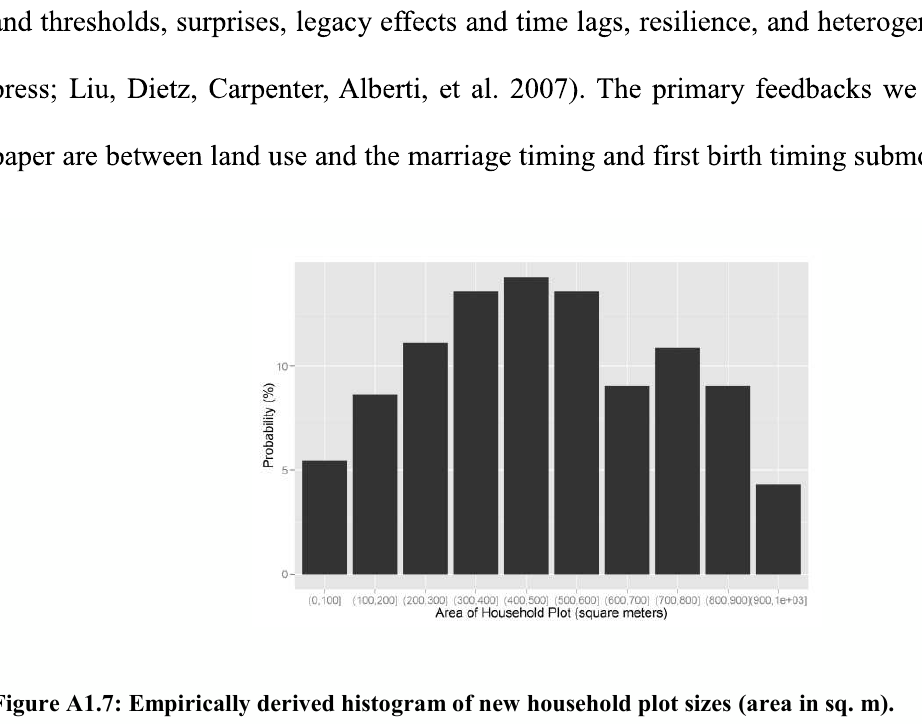
Figure A1.7: Empirically derived histogram of new household plot sizes (area in sq.